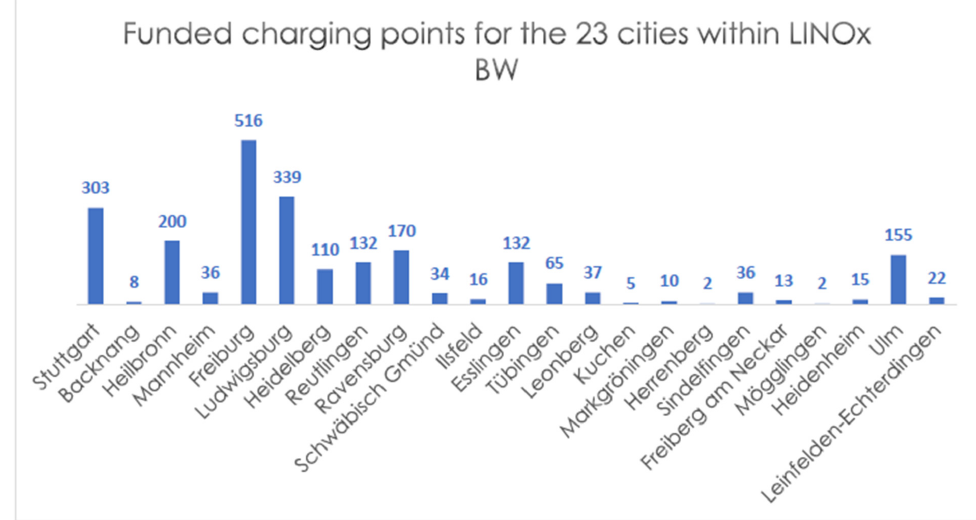
Figure 1. Funded charging points for the 23 cities within LINOx BW.